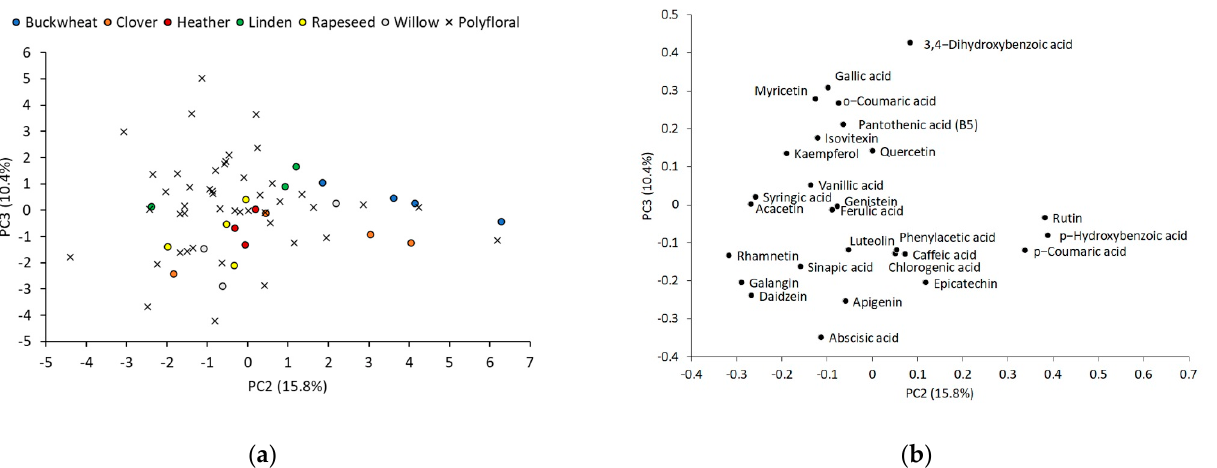
Figure 4. PCA of monofloral buckwheat, clover, heather, linden, rapeseed, willow, and polyfloral honey samples: ( a ) score plot between PC2 and PC3, and ( b ) loading plot of 27 organic compound concentrations obtained by UHPLC-HRMS.